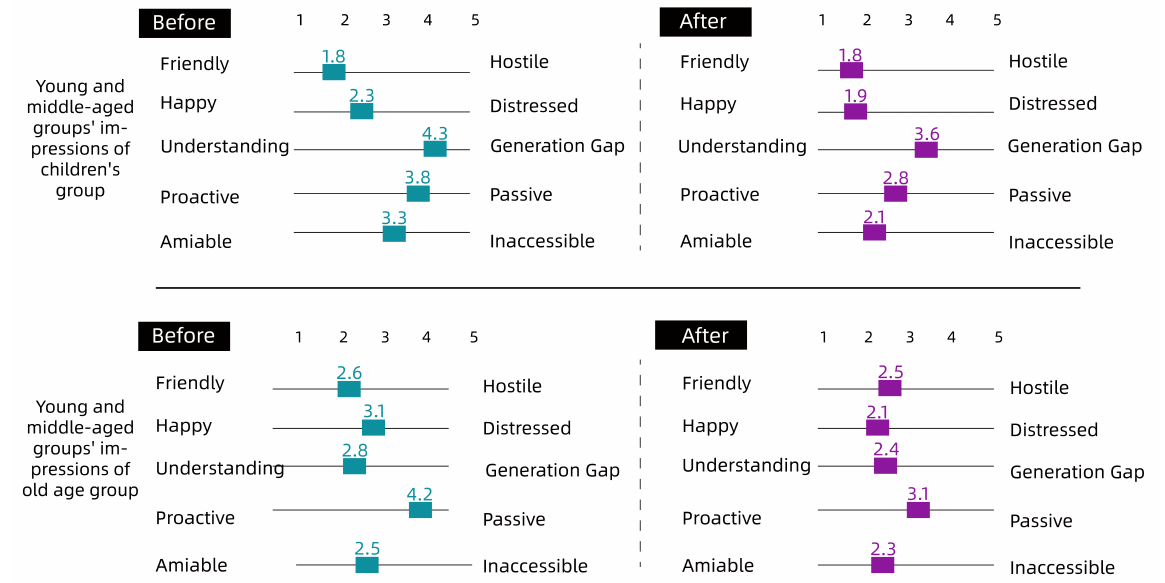
10Figure 9. Young and Middle-Age Groups’ Impressions of Different Ages. After the intervention, the perceived impressions of the middle-aged and young adult groups were more proactive and approachable than before, while the attitudes toward children were perceived as more friendly and more welcoming than those of the older